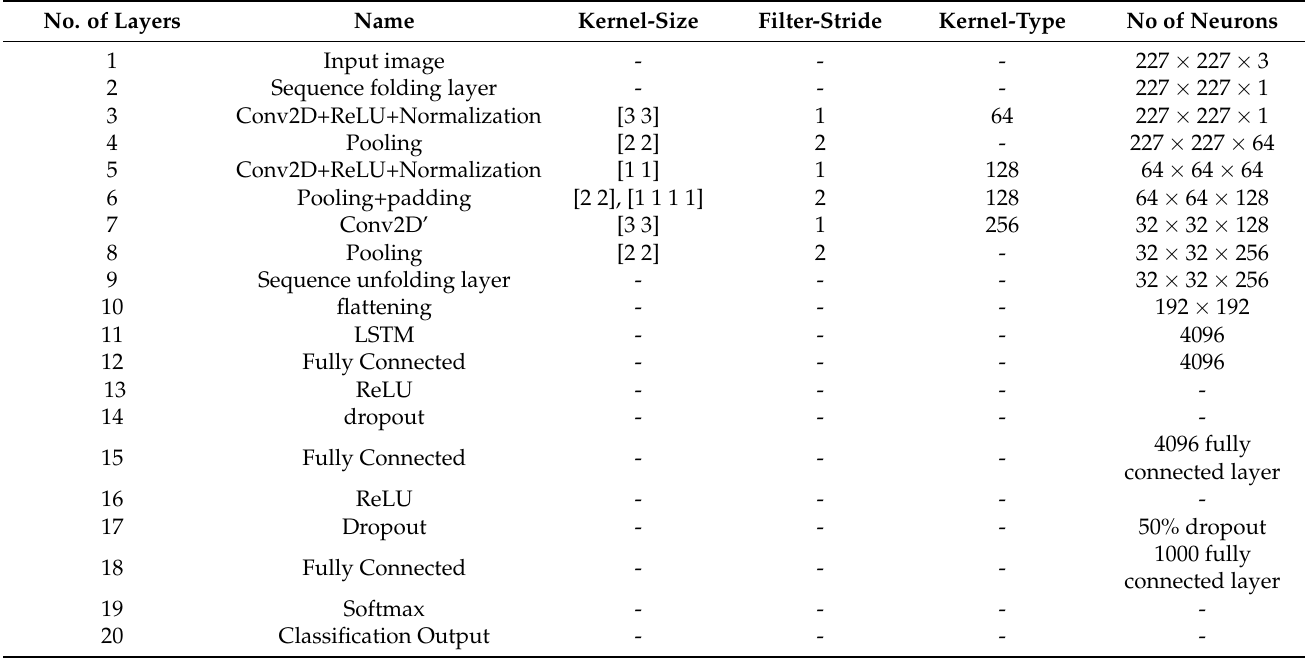
Table 2. Representation of Complete Layer Architecture of Proposed Model